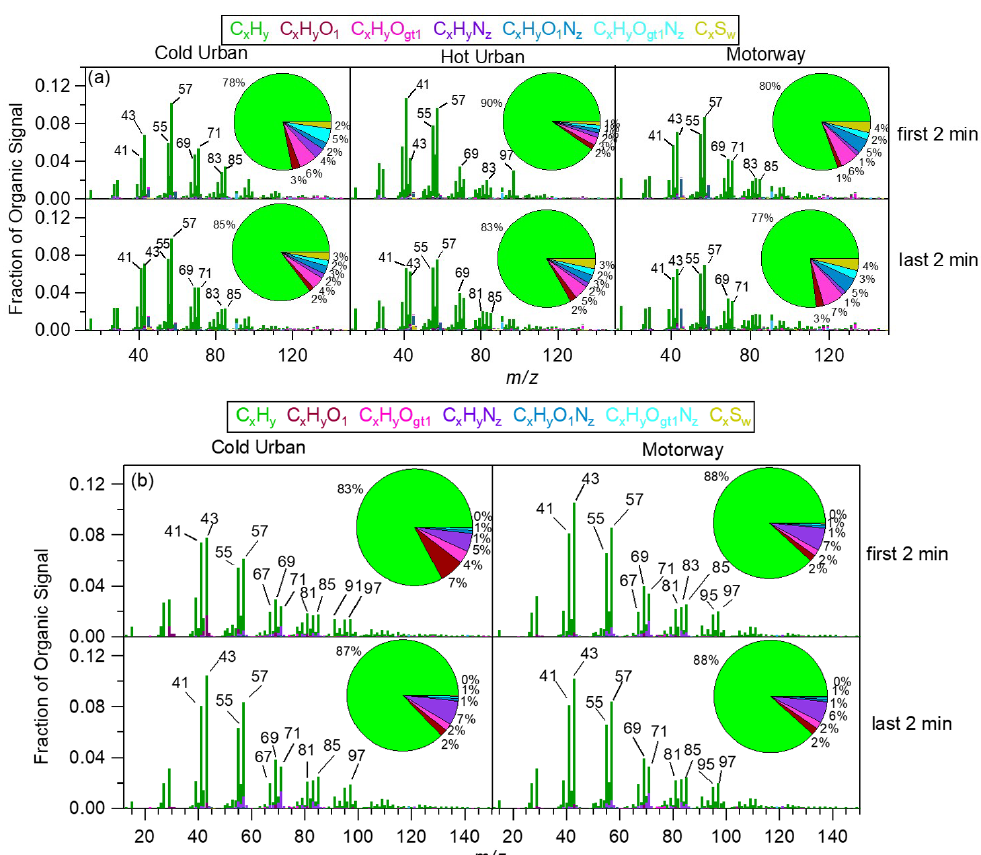
Figure 3. HR mass spectra and chemical composition: (a) during the first 2 and the last 2min of a cold urban (left), hot urban (middle), and motorway (right) Artemis cycle for the gasoline GDI3 vehicle and (b) during the first 2 and the last 2min of a cold urban (left) and a motorway (right) Artemis cycle for the diesel D3 vehicle. Table 2. Correlations between mass spectra taken during the first 2min of an Artemis motorway cycle and mass spectra from diesel and gasoline vehicles, lubricant oil, and PMF factors related to fresh transportation (HOA, hydrocarbon-like OA) from selected studies using both R 2 and the angle θ (Kostenidou et al., 2009) in parentheses. The angle θ provides a better comparison for small differences in the mass spectra (when R 2 is less than 0.97), as this method treats the mass spectra as vectors. More details about this method are given in Kostenidou et al.